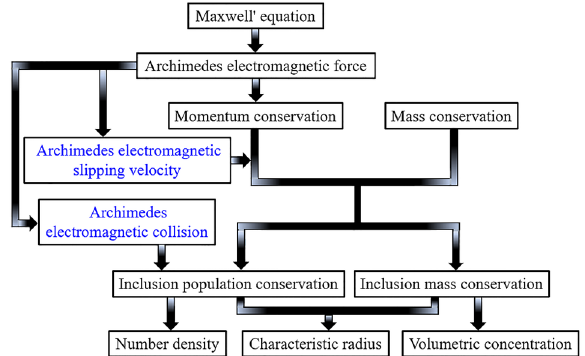
Figure 2. Calculation procedure of the mathematical model.